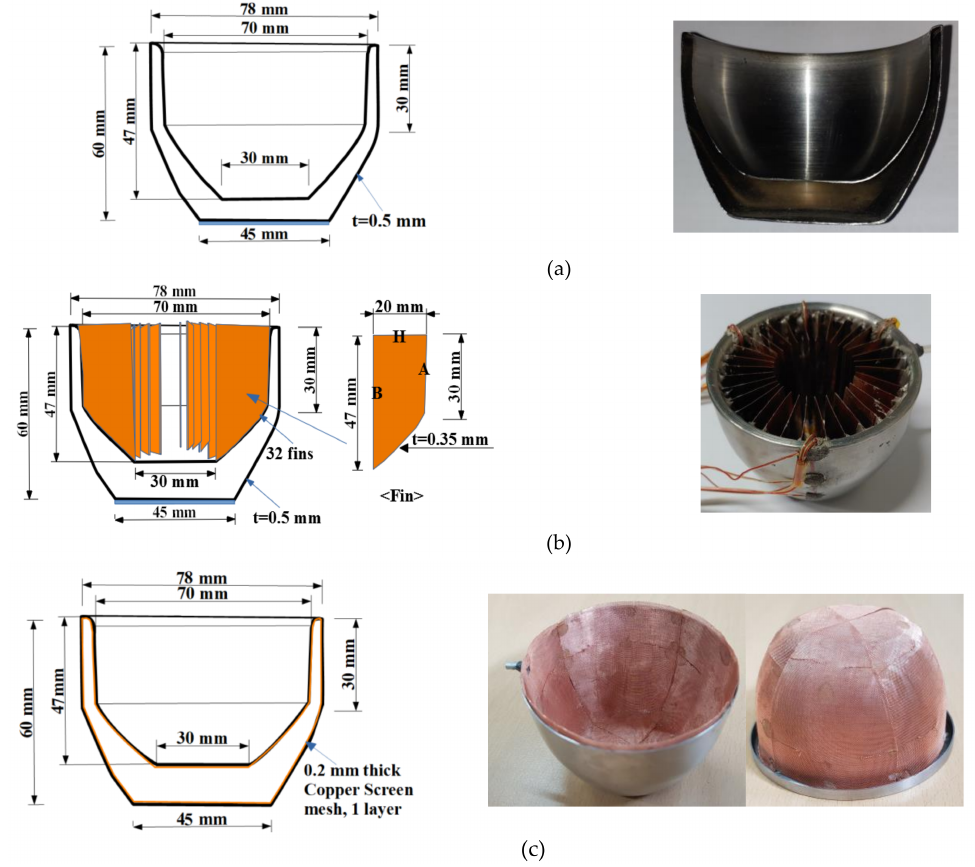
Figure 3. Hemispherical shell vapor chambers for the experiments. ( a ) Model 1 (dimension and cross-sectional view); ( b ) Model 2 (dimension and finned condenser view); ( c ) Model 3 (dimension and wicked inner